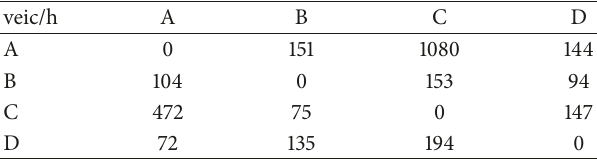
Table 3: O/D matrix for Cosmai Roundabout.